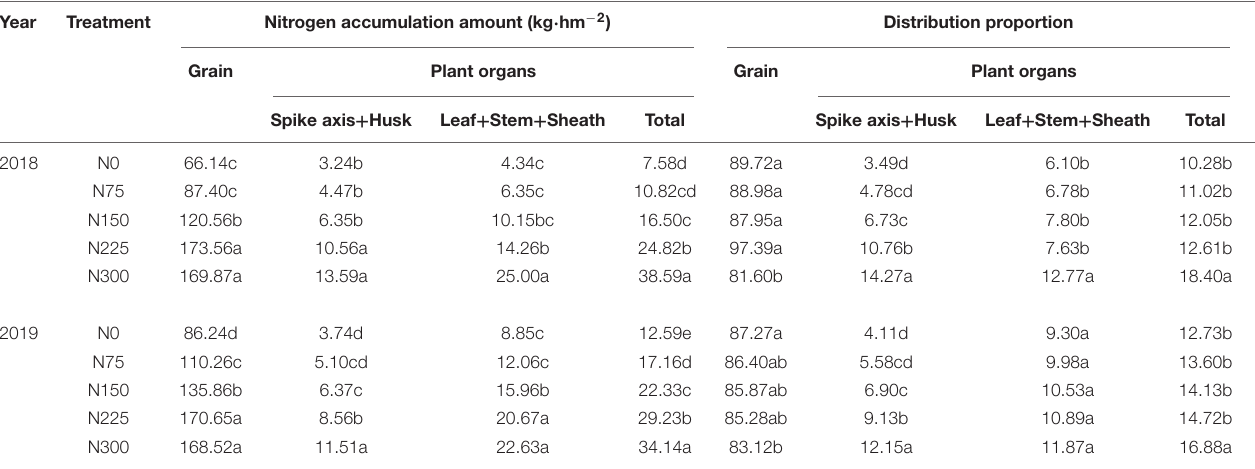
TABLE 4 | Nitrogen accumulation and distribution proportion in different organs at maturity stage of winter wheat in 2018 and 2019 under different nitrogen application rates. Year